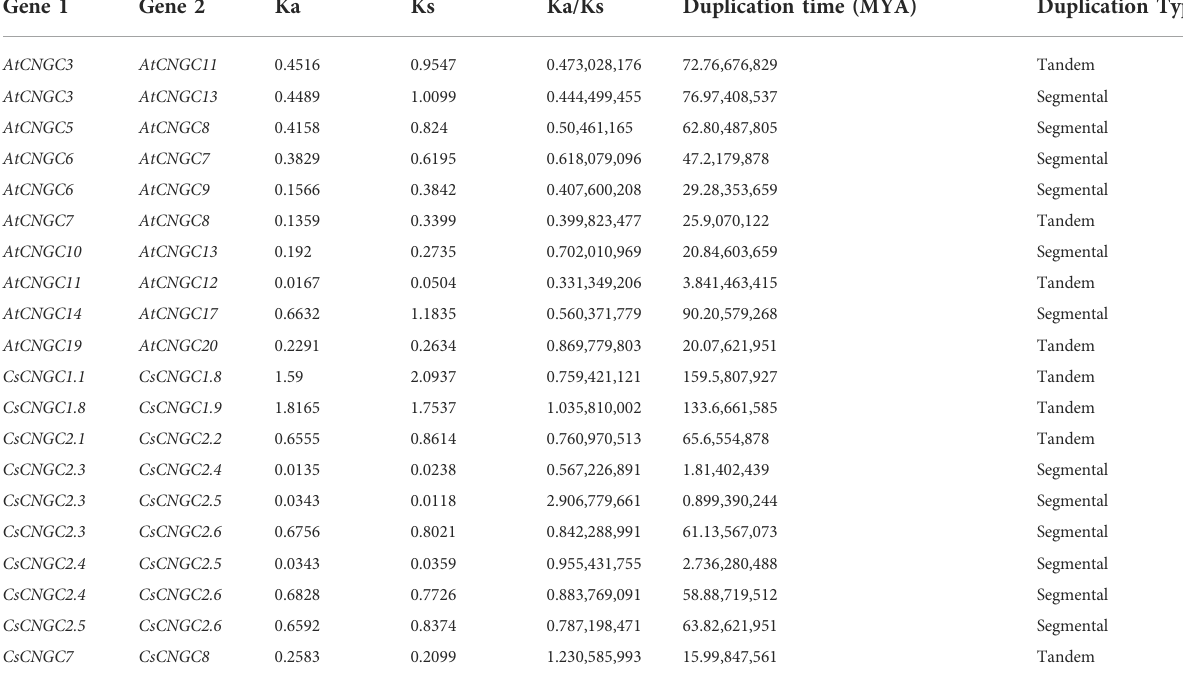
TABLE 3 Ka, Ks, Ka/Ks values calculated for homologous gene pairs of A. thaliana and C. sinensis